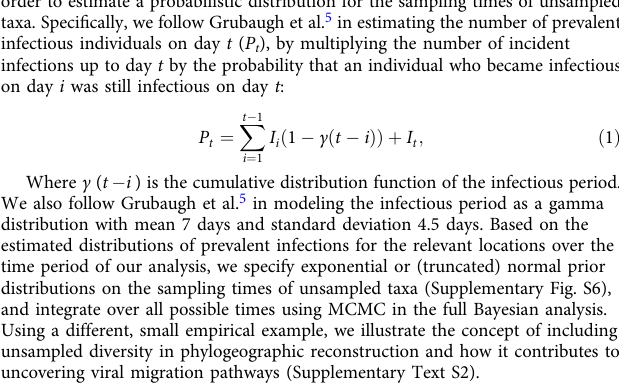
FigTree v.1.4.4. However, due to the limitations of single-tree representations when facing extensive phylogenetic uncertainty, we also propose new summaries below.